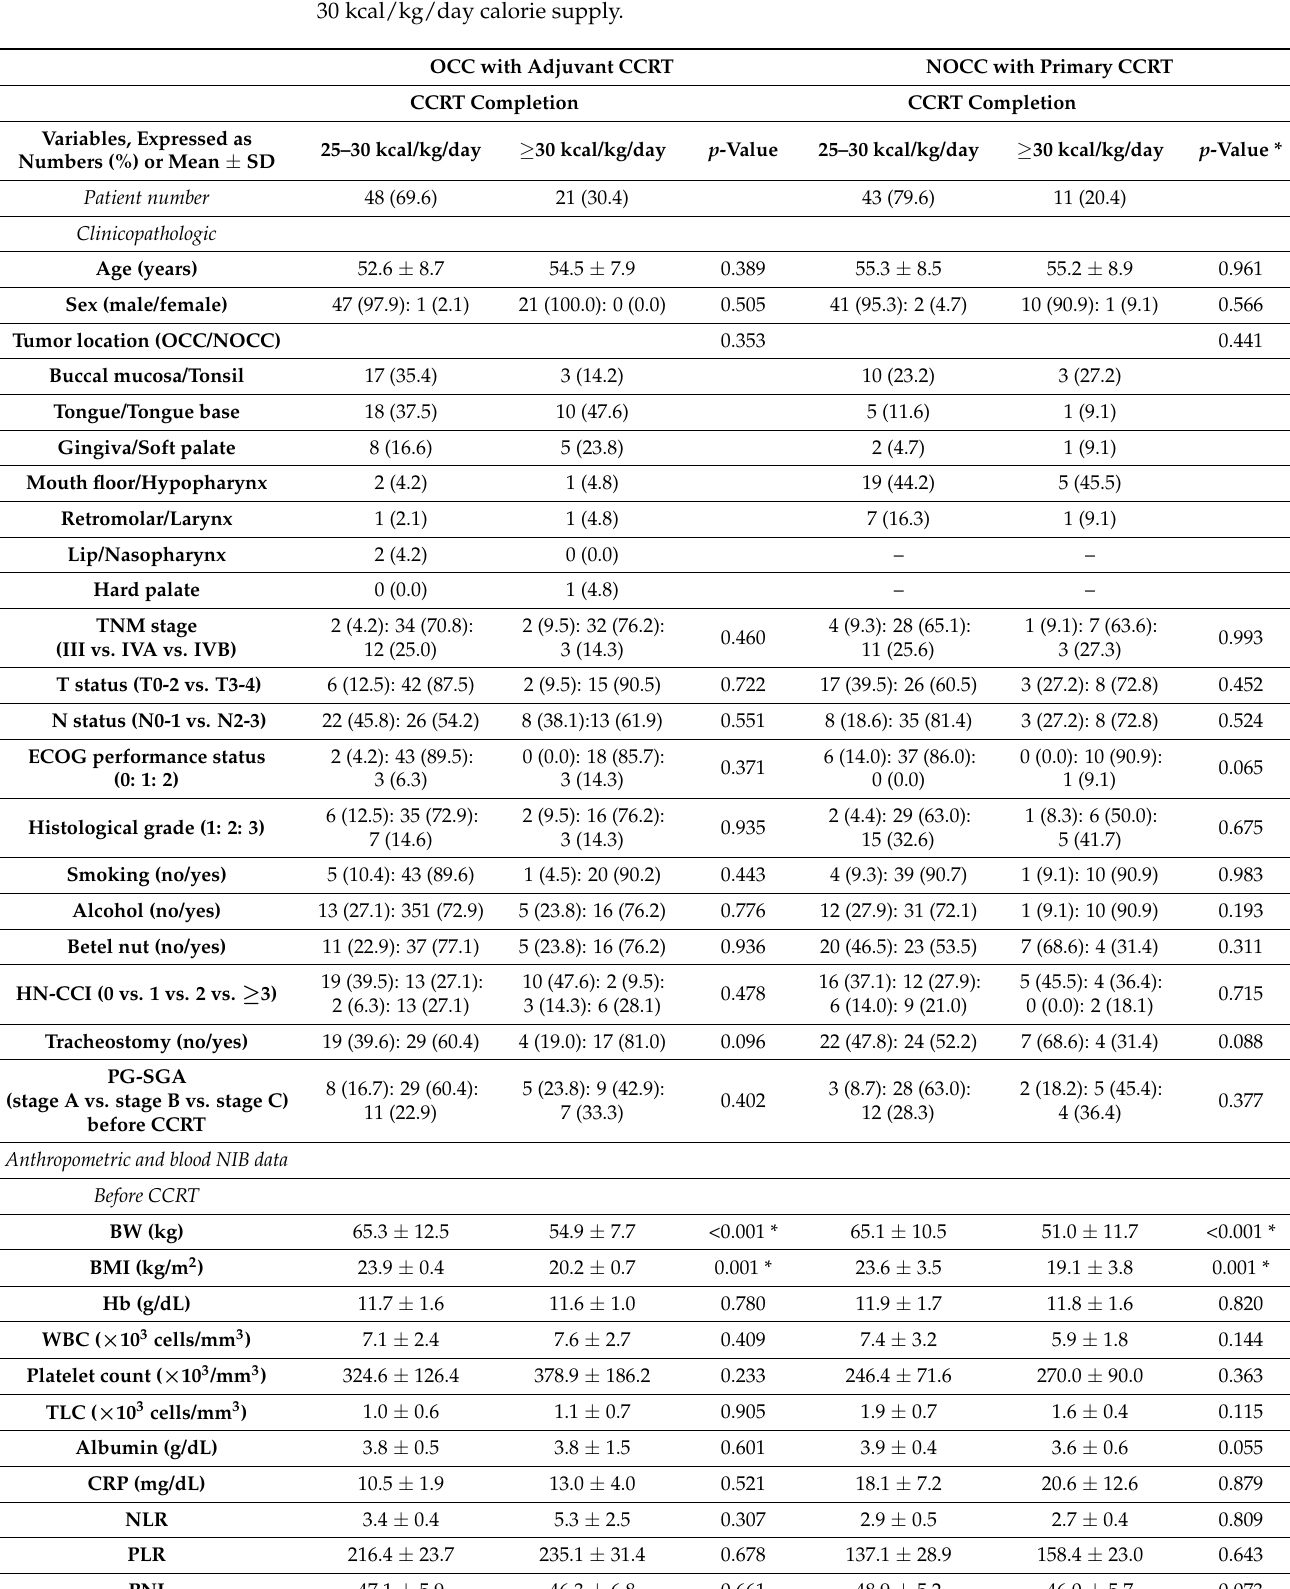
Table 2. Baseline characteristics and treatment interval changes during the CCRT course in 123 pa- tients with LAHNSCC undergoing CCRT stratified by tumor location and CCRT settings stratified by 30 kcal/kg/day calorie